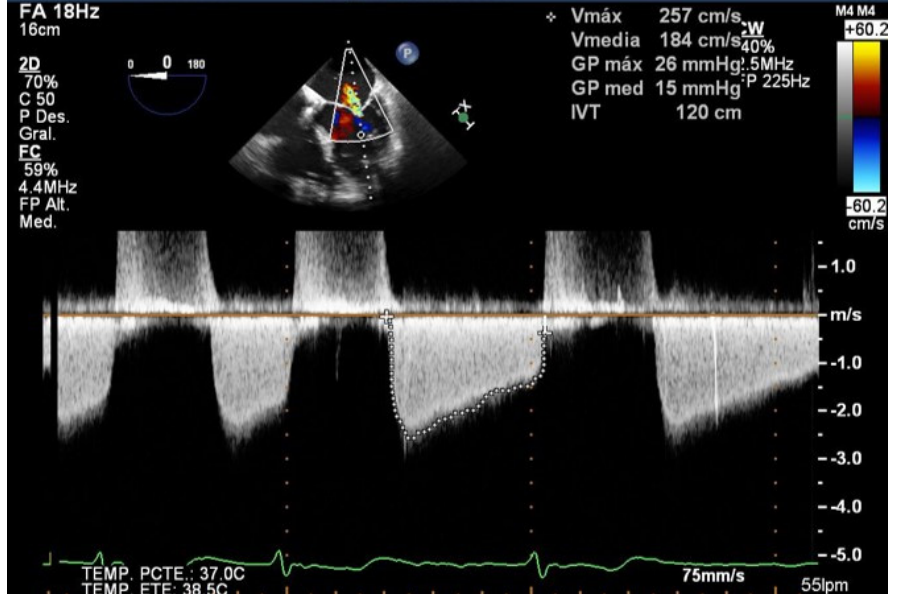
Figure 3. Severe mitral stenosis after implantation of a mitral clip measured by Doppler